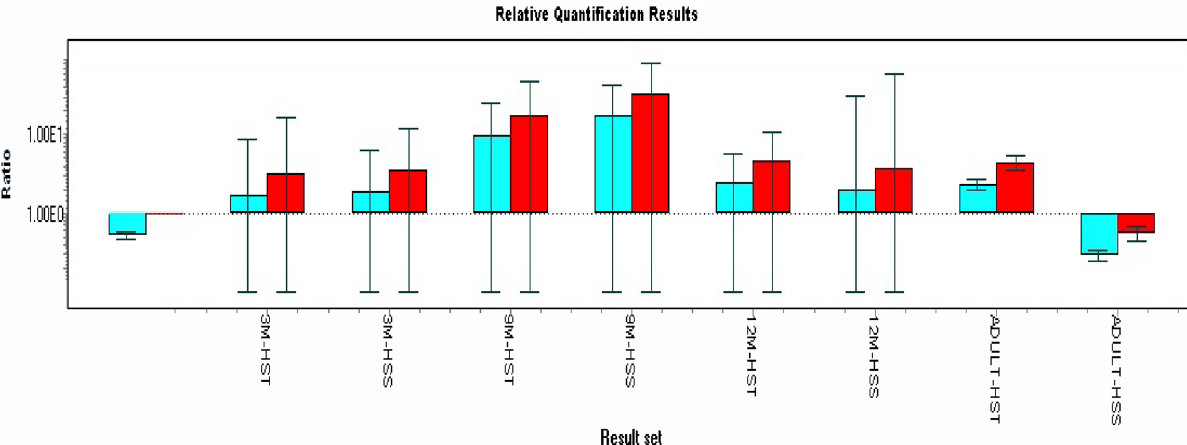
Figure 2. Relative mRNA expression (Fold change) of HSP70 gene at different age groups of Jamunapari goat with respect to HST and HSS phenotype. 3 M-HST, 3-Month age of animal- Heat stress tolerant phenotype; 3 M-HSS, 3-Month age of animal-Heat stress susceptible phenotype; 9 M-HST, 9-Month age of animal-Heat stress tolerant phenotype; 9 M-HSS, 9-Month age of animal-Heat stress susceptible phenotype; 12 M-HST, 12-Month age of animal-Heat stress tolerant phenotype; 12 M-HSS, 12-Month age of animal-Heat stress susceptible phenotype; Adult-HST, Adult (2–3 year) age of animal- Heat stress tolerant phenotype; Adult-HSS, Adult 92–3 year) age of animal- Heat stress susceptible phenotype. The crossing point (Cp) readings for each unknown sample were then used to calculate the amount of either the target or housekeeping gene using the second derivative maximum method with the Light cycler 480 analysis software version 1.5 (Roche Applied Science, Indianapolis, IL, USA). GADPH and β-actin were used to normalize gene expression. The susceptible individual was used as a positive calibrator to obtain normalized gene